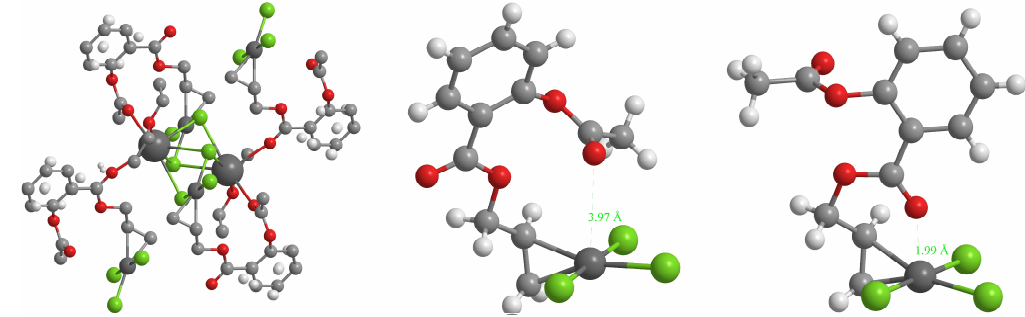
Figure 3. Left: K + interactions in the crystal of 1a ; middle: single molecule of 1a ; right: conformational change of the ASA moiety in 1a Table 1. Selected bond lengths and bond angles in the crystal of 1a .